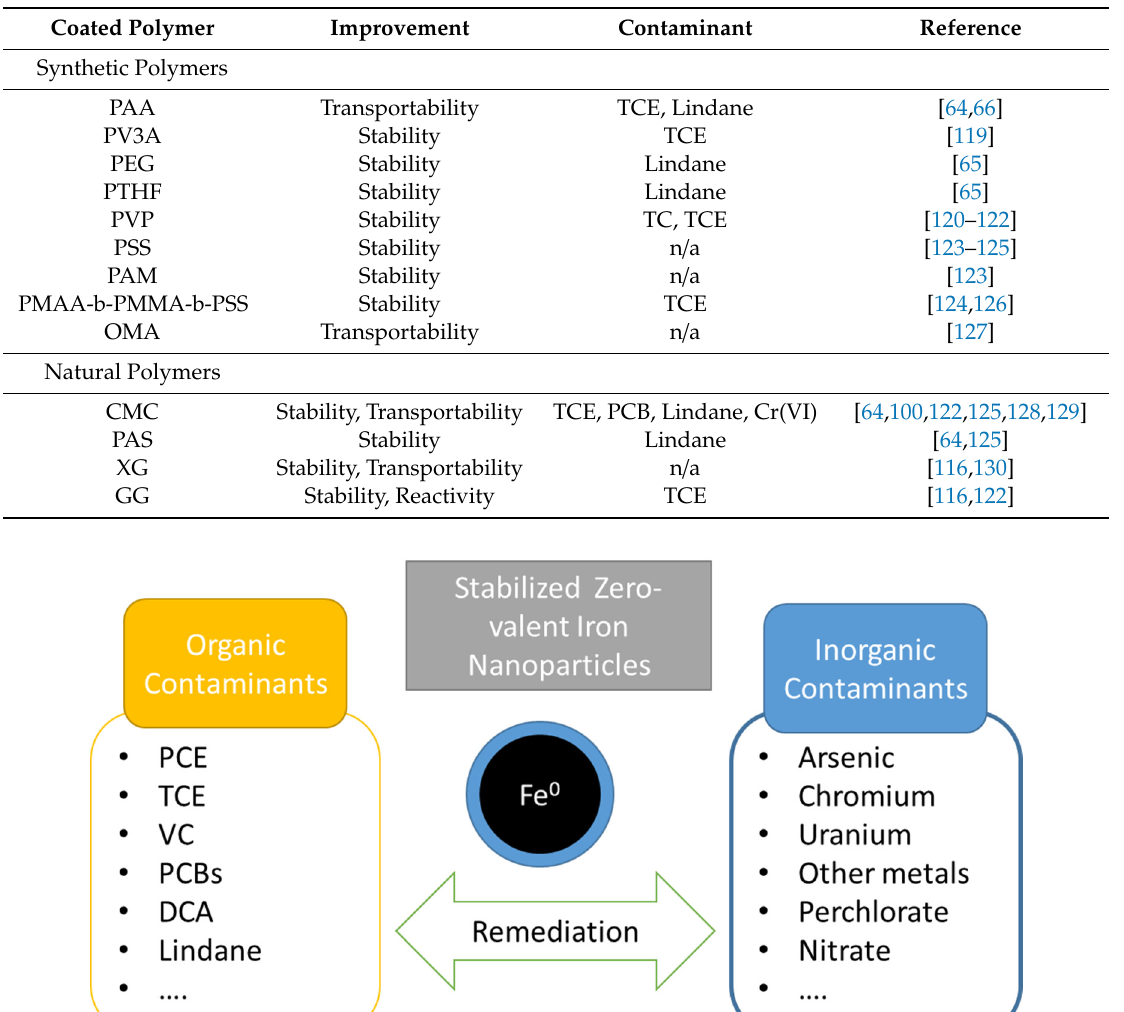
Table 5. Summary of main examples of polymer coated NZVI.